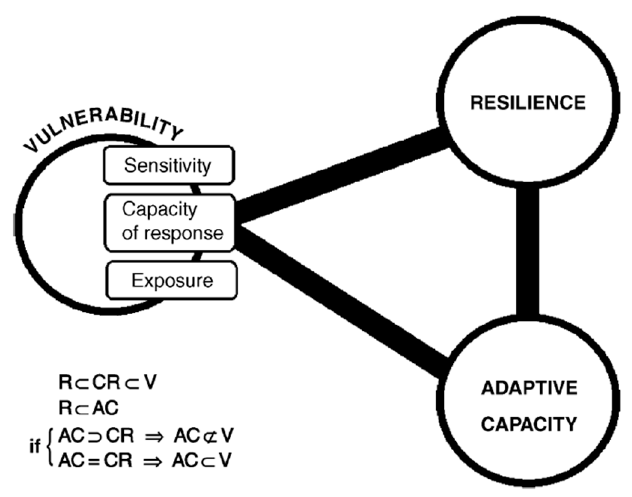
Figure 2. A diagrammatic summary of the conceptual relations between vulnerability, resilience, and adaptive capacity. (The R, V, AC, and CR stand for resilience, vulnerability, adaptive capacity, and capacity of response, respectively.)